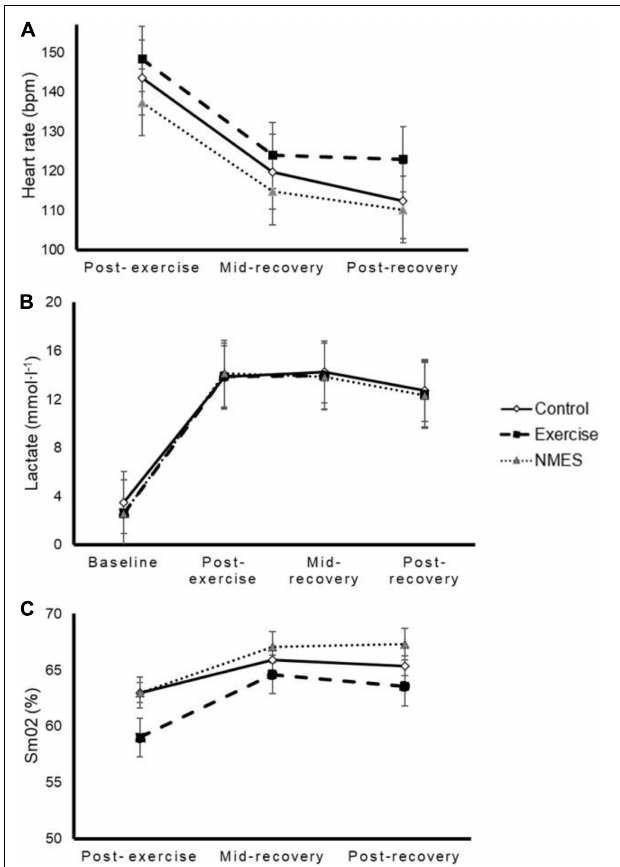
FIGURE 3 | Effects of low-intensity exercise (Exercise), surface neuromuscular electrical stimulation (NMES) or total rest (Control) on heart rate (panel A ), blood lactate (panel B ), and muscle oxygen saturation (SmO 2 , panel C ). No significant interaction effect was found ( p = 0.920, p = 0.831, and p = 0.694, respectively).